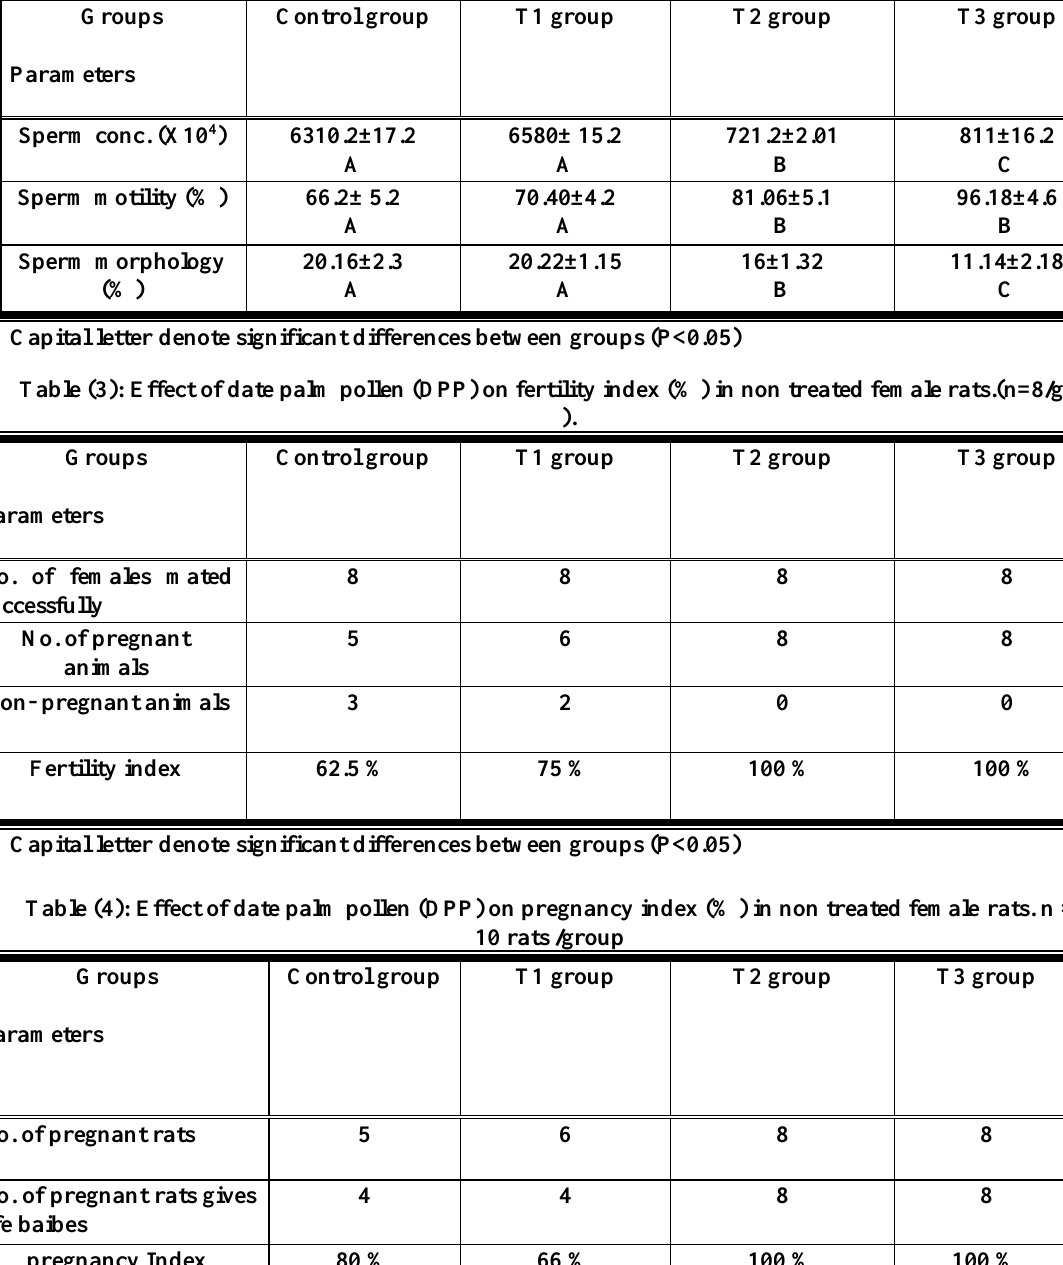
Table (2): Effect of date palm pollen (DPP) on sperm parameters. ± S.E,n = 10 rats /group Groups